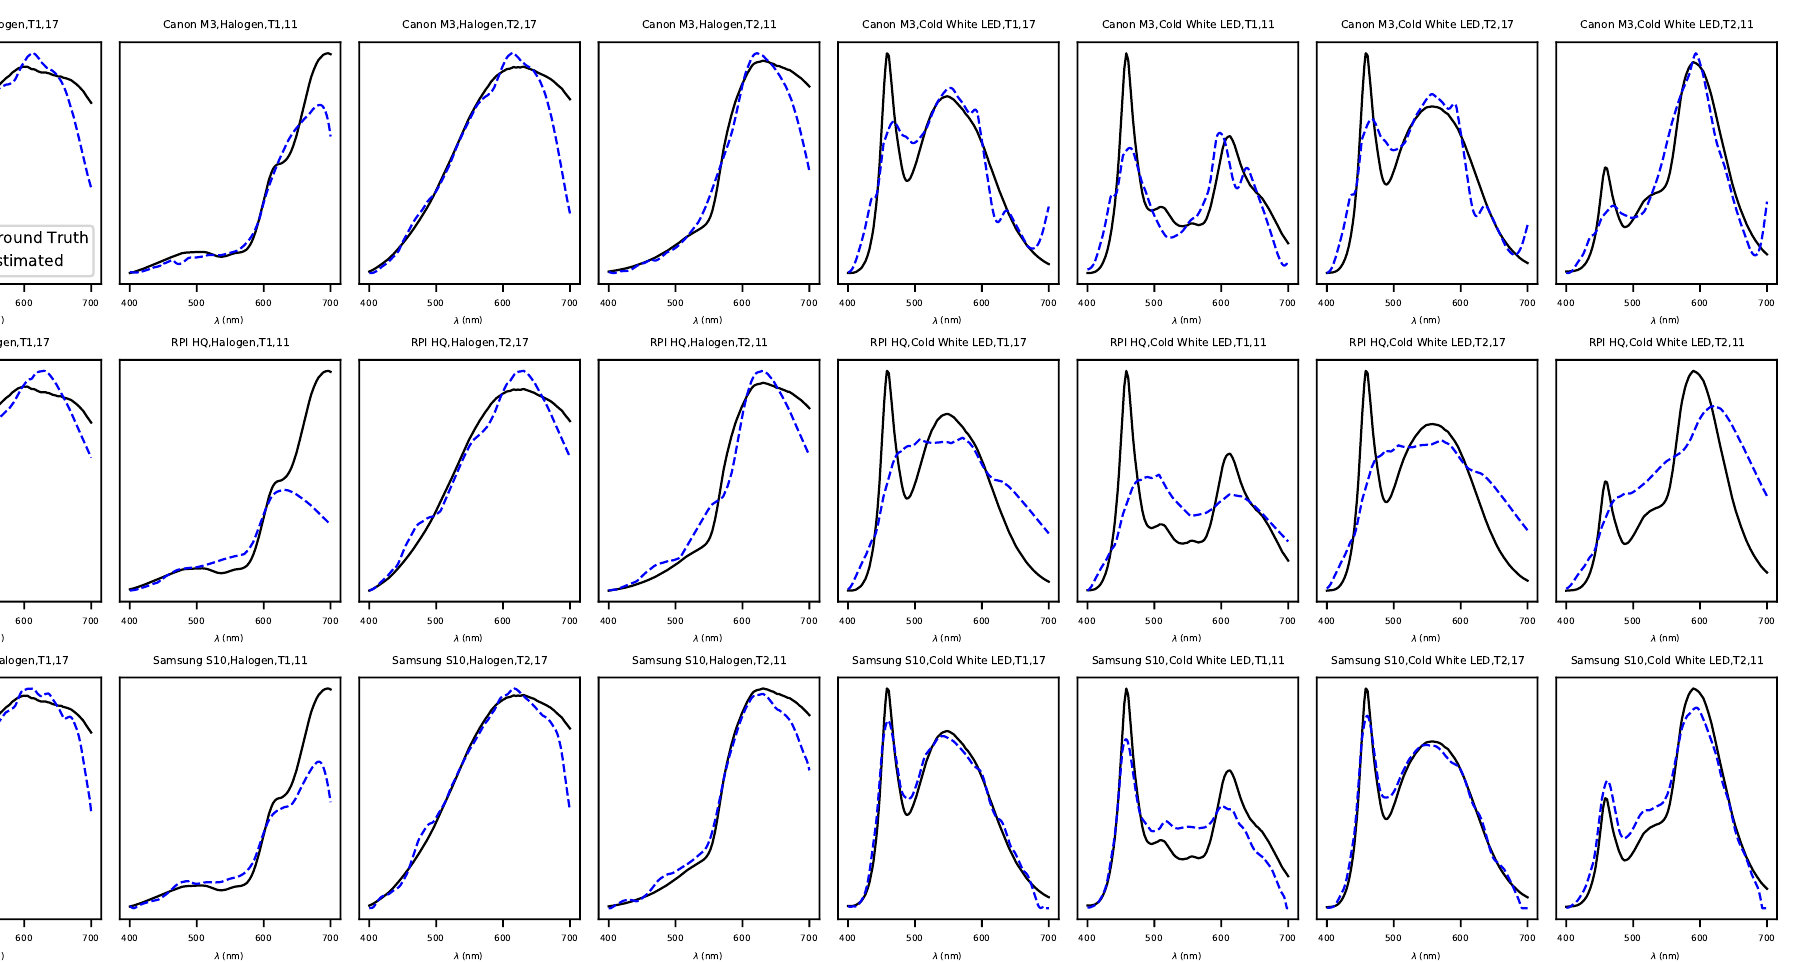
Figure 8. A random selection of relative spectra estimated using the best presented method, the non-negative deconvolution model (blue dashed line) compared against the relative ground truth spectra (black solid line). Each row shows spectra for a single camera with the first half of columns imaged under halogen illumination and the second half under cold white LED